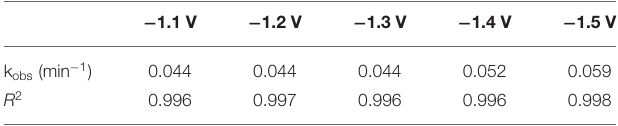
TABLE 1 | Value of k obs and R 2 for each studied